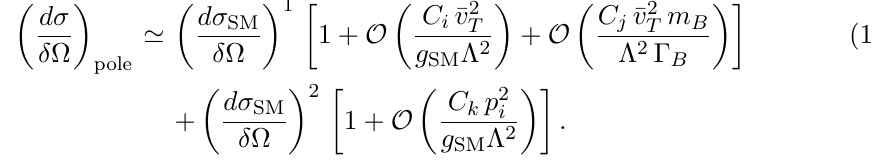
(6) and shifts are only shown on L (cid:1) (cid:1) (cid:1)